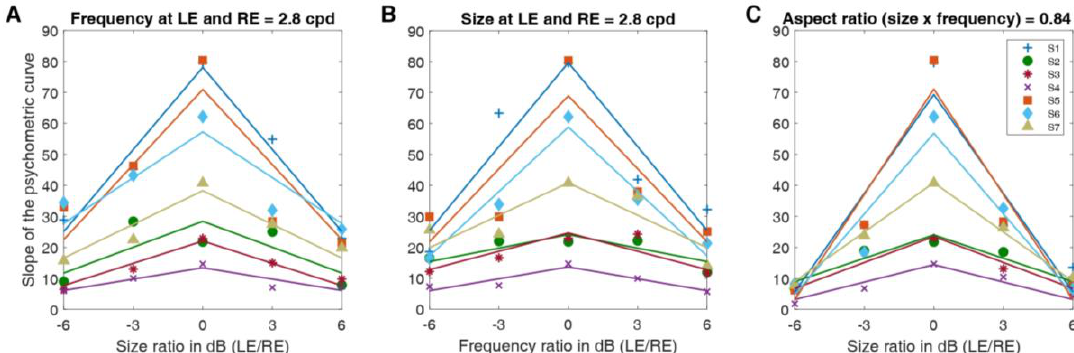
Figure 6. Slopes of the psychometric curve as a function of either size or spatial frequency ratio between the Gabor elements shown to the left and right eye. ( A ) Individual subjects’ slopes of the psychometric curve ( y -axis), as a function of the size ratio between the left and right eye’s Gabor elements when the frequency of the Gabor elements presented to both eyes is 2.8 c / d. Fitted lines represent fits with an inverted absolute value function for each subject. ( B ) Individual subjects’ slopes of the psychometric curve ( y -axis) as a function of the spatial frequency ratio between the Gabor elements when the size of the Gabor elements presented to both eyes is 0.3 deg. Fitted lines represent fits with an inverted absolute value function for each subject. ( C ) Individual subjects’ slopes of the psychometric curve ( y -axis) as a function of the frequency ratio between the Gabor elements shown to the left and right eye when the aspect ratio remains at 0.84 cycles for both eyes. Aspect ratio is the product of spatial frequency and size. Fitted lines represent fits with an inverted absolute value function for each subject.